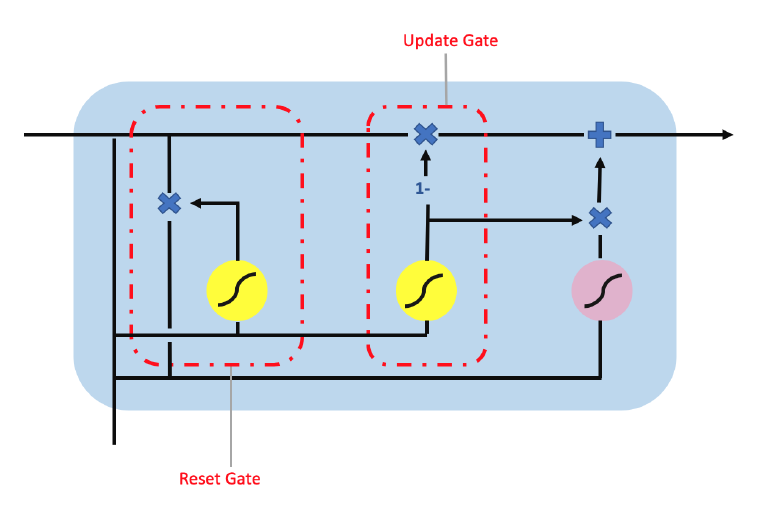
Figure 7. The gated recurrent unit (GRU) unit contain a reset gate and update gate. The yellow circle represents the sigmoid activation function while the pink circle represents a tanh activation function. Additionally, the ”x”, “+”, and ”1 − ” symbols are the element-wise multiplication, addition, and inversion